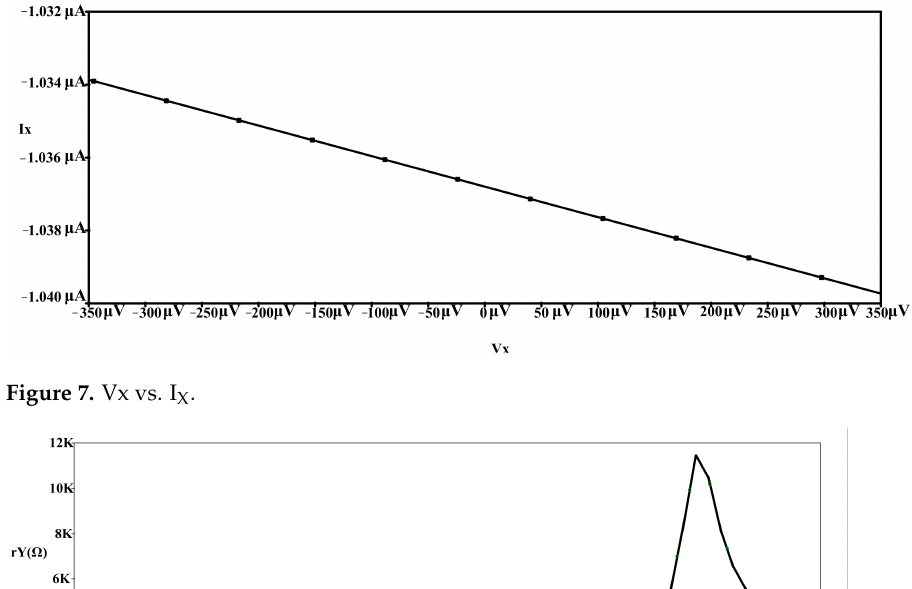
Figure 7. Vx vs. I X .